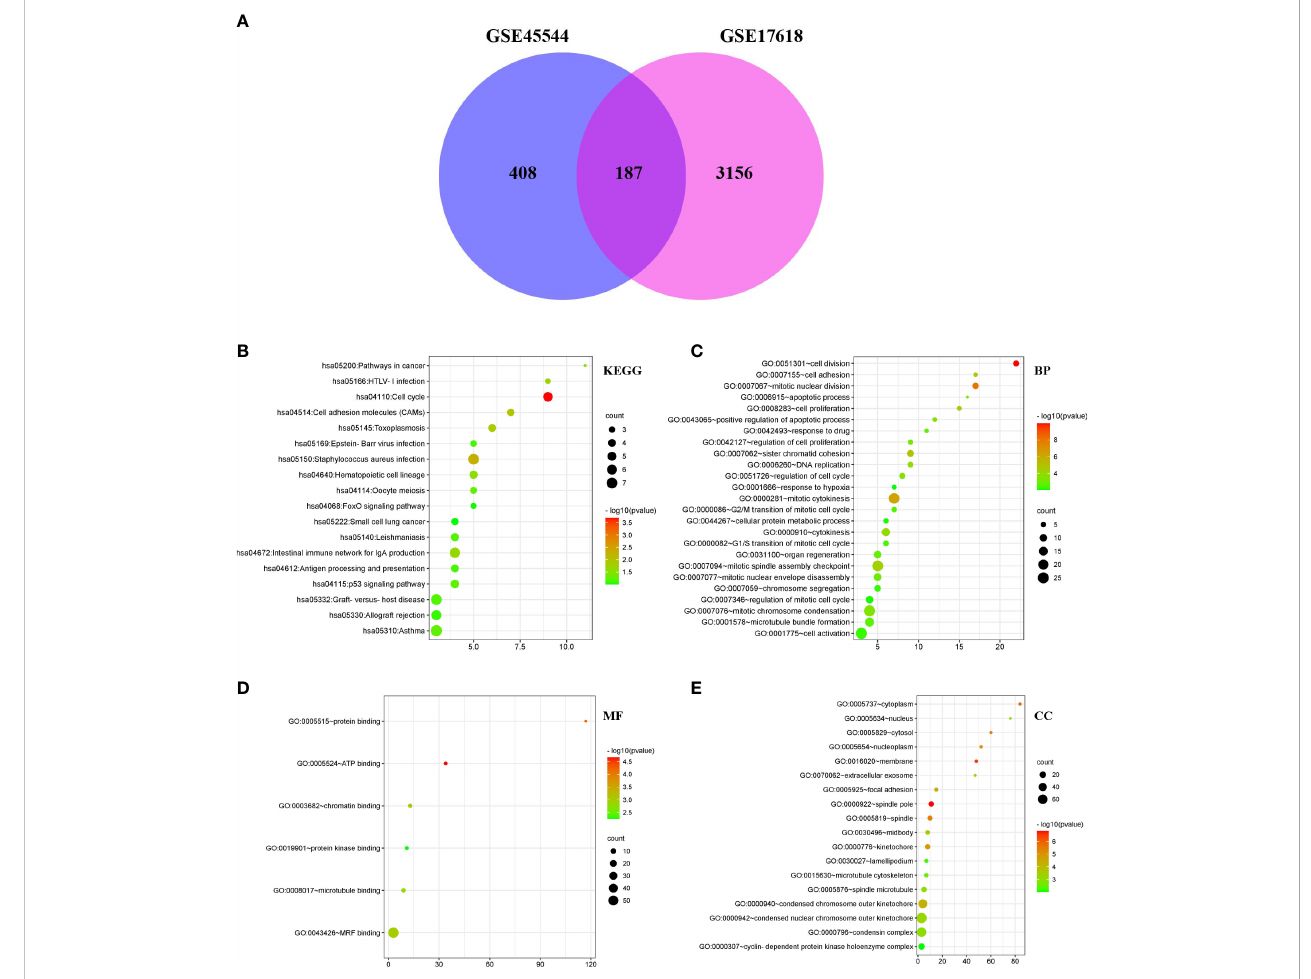
FIGURE 2 DEG Venn diagram; Bubble Plot of the GO and KEGG enrichment study for DEGs. (A) DEGs in the GSE17618 and GSE45544 mRNA expression pro fi ling datasets were fi ltered with a fold change > 2 and a P value < 0.01. 187 genes overlapped between the two datasets. (B – E) The P value is shown by the progressively shifting hue, and the quantity of genes is denoted by the size of the black